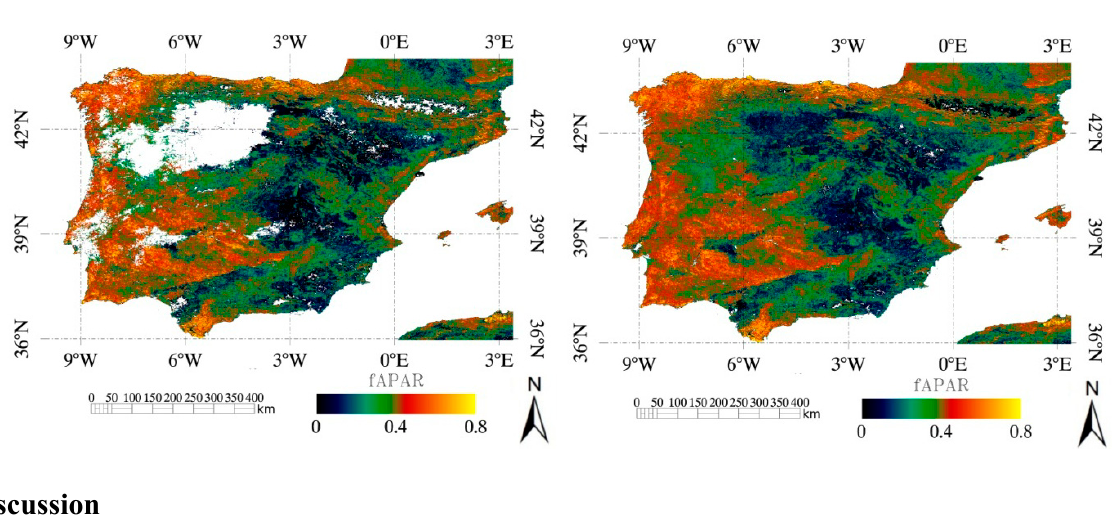
Figure 9. fAPAR values for the Iberian Peninsula before ( left ) and after ( right ) the application of the adapted LOESS method for filtering and interpolation using real MODIS data (products MCD43A1 and